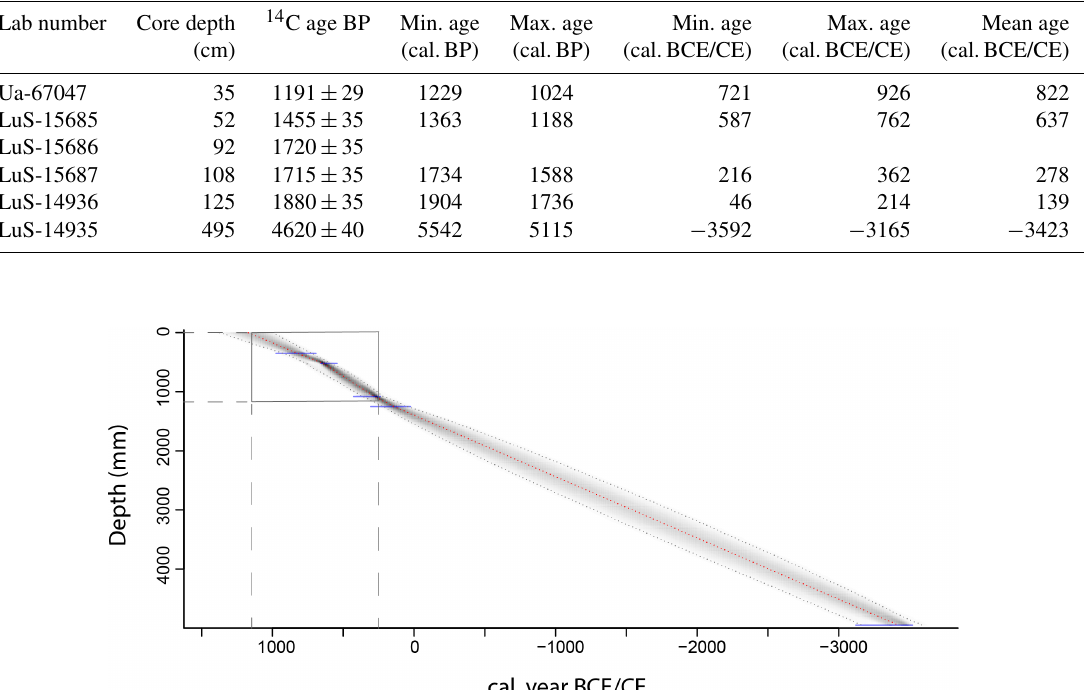
Figure A7. Age–depth model Ulbergmyr peat sequence, represented with the RBacon package. The section in the rectangle indicates the study period